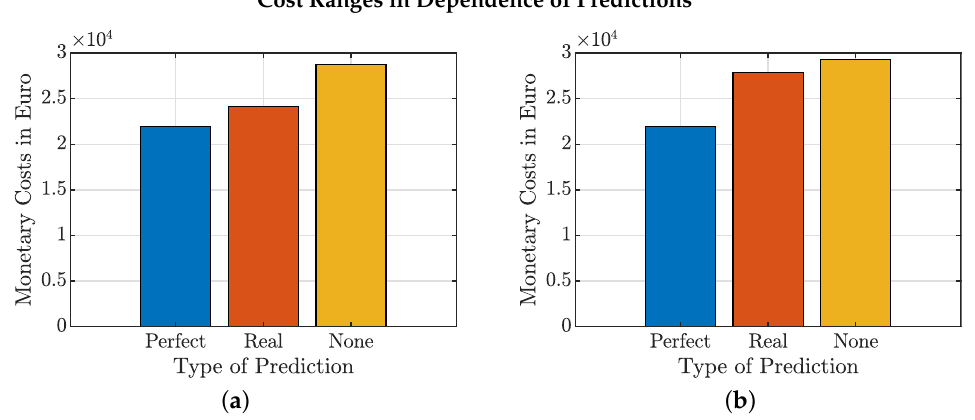
Figure 5. Monetary costs for simulations with perfect, real or no predictions. The initial peak was set to 100 kW (for which peak costs are included). The pessimistic scenario shows overall higher costs if prediction errors are present. ( a ) Optimistic Scenario; ( b ) Pessimistic Scenario.